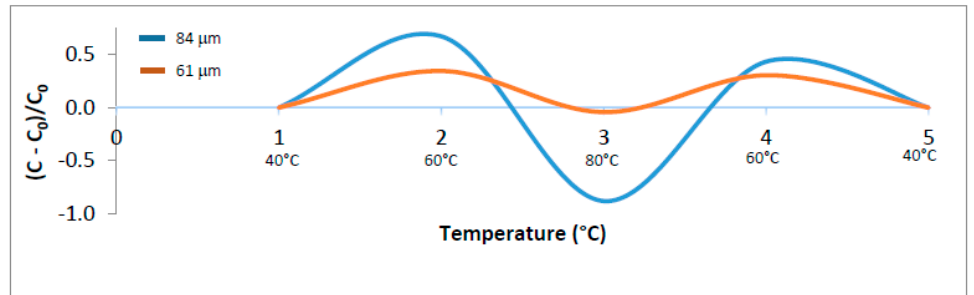
Figure 3. Effect of temperature on the capacitance of gelatin (expressed by ( C − C 0 )/ C 0 ): thickness of 84 µm and 61 µm at 868 MHz and humidity of 90% RH: C (capacitance at 40 °C, 60 °C, 80 °C); C 0 (capacitance at 40 °C).